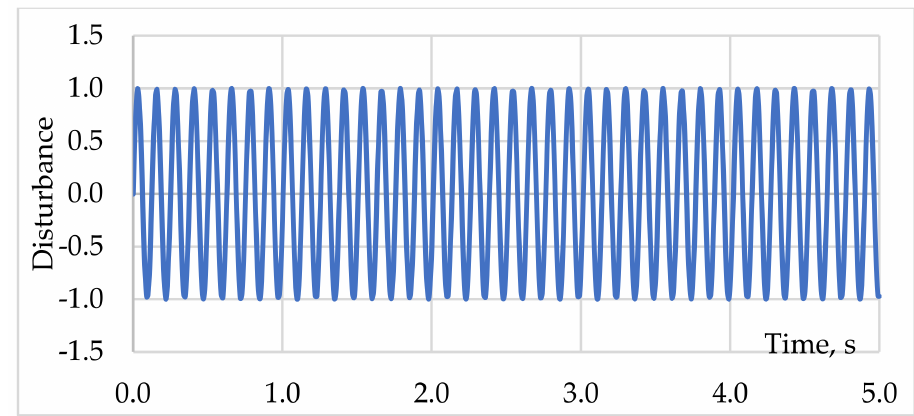
Figure 5. Unknown external disturbance variation over time.